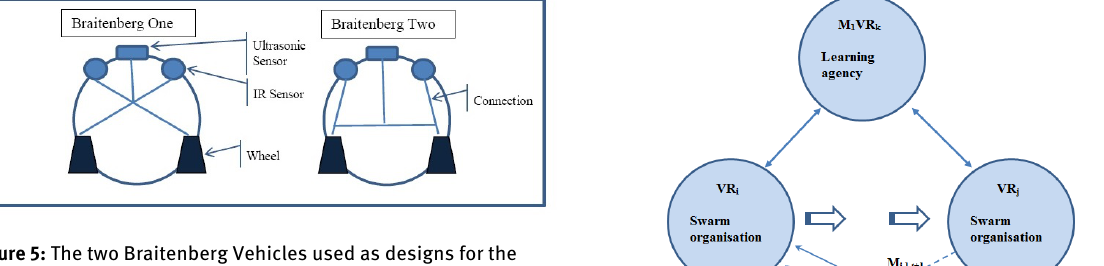
, R , R , R , R ; each in 1 2 3 4 5 and VR i j VR 1 k